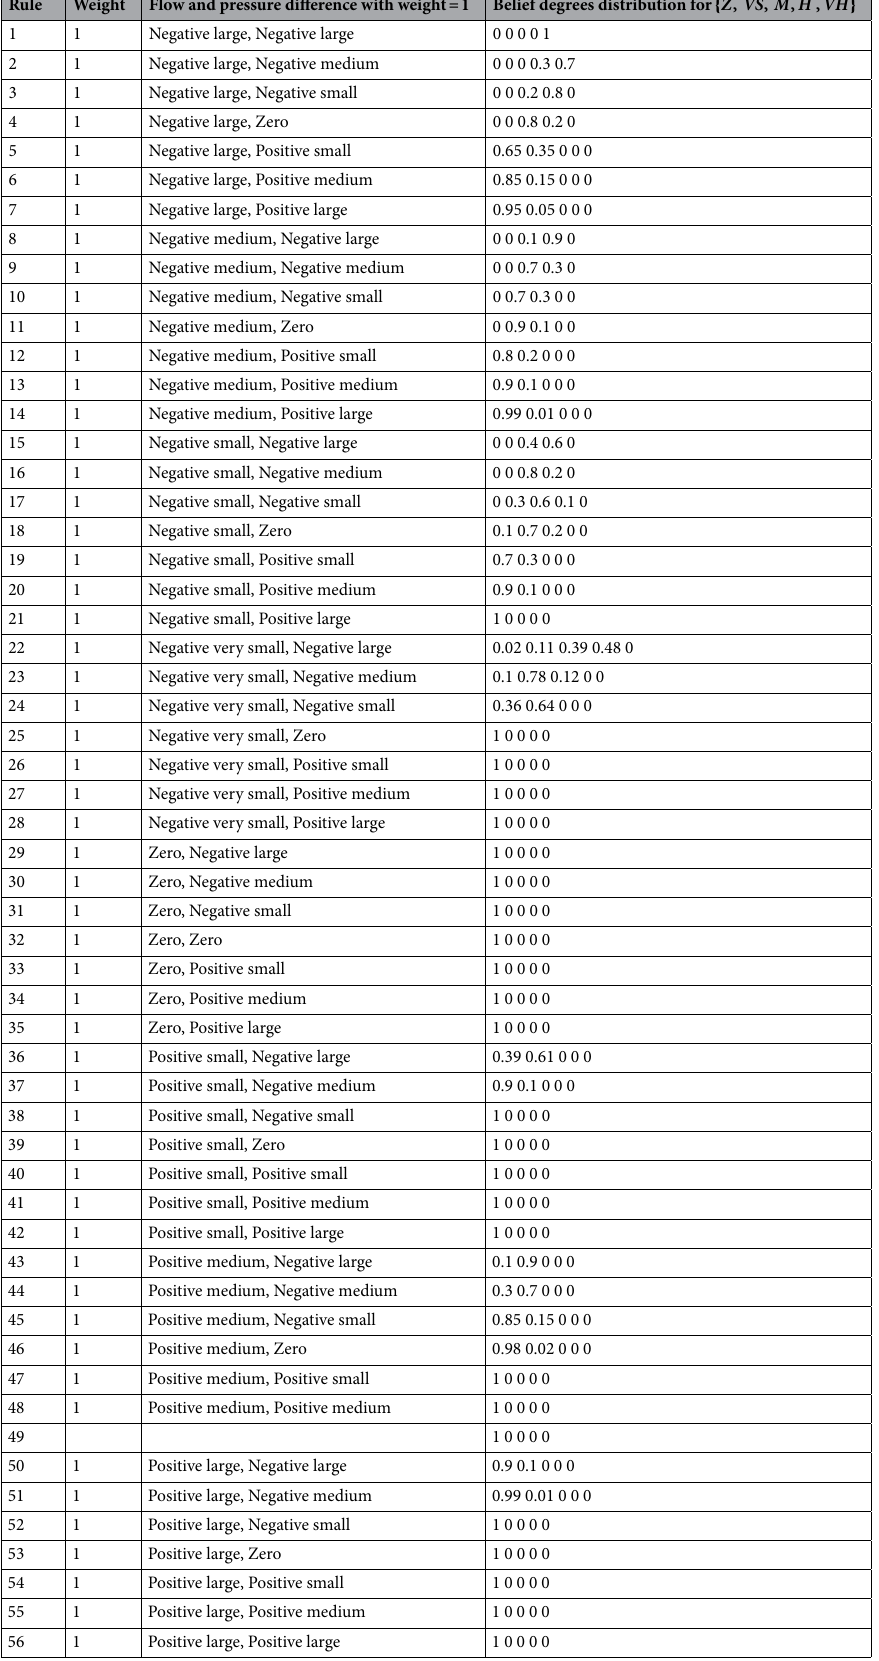
Table 13. Initial parameters of BRB expert